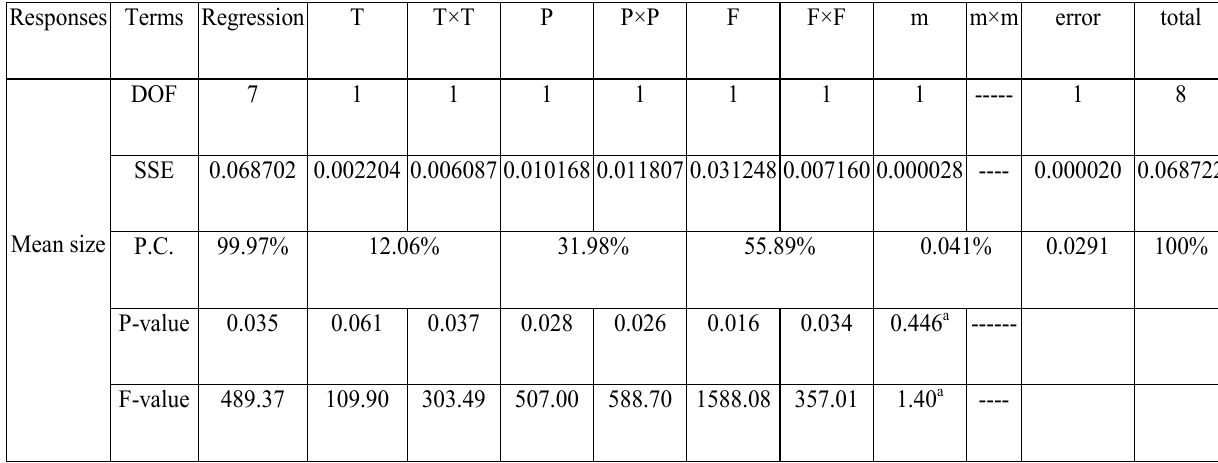
ANOVA of granule mean size (with pooling process).